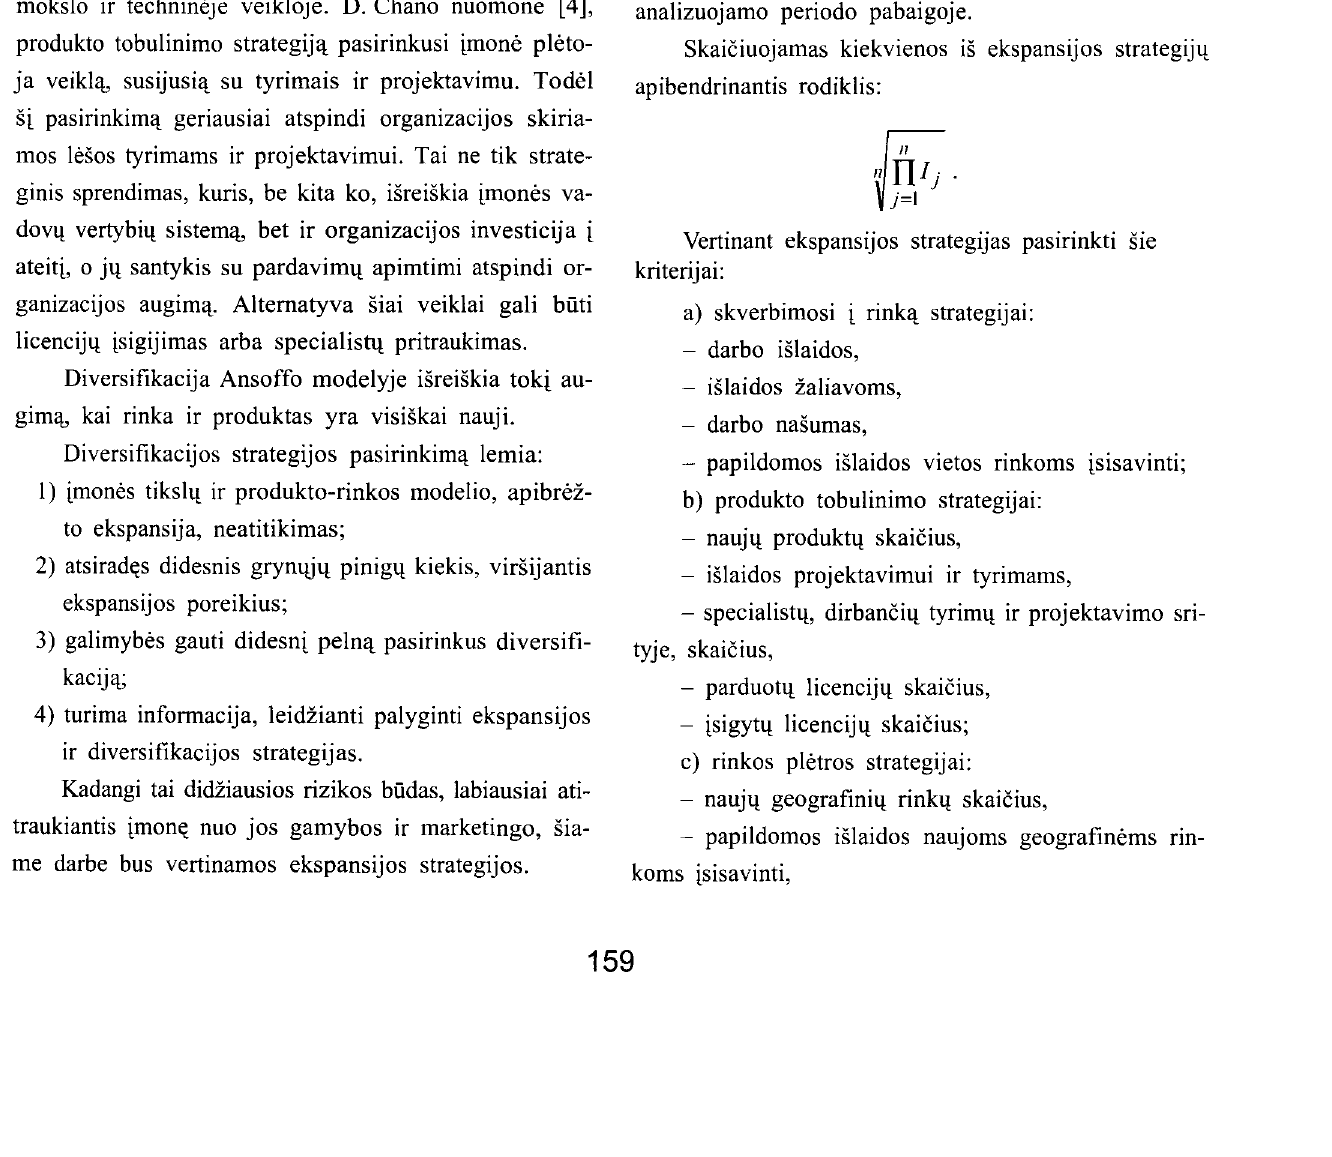
rna uzimant naujus rinkos segmentus, siulant nauj~ pro dukt<l_ ar skverbiantis i naujas geografines